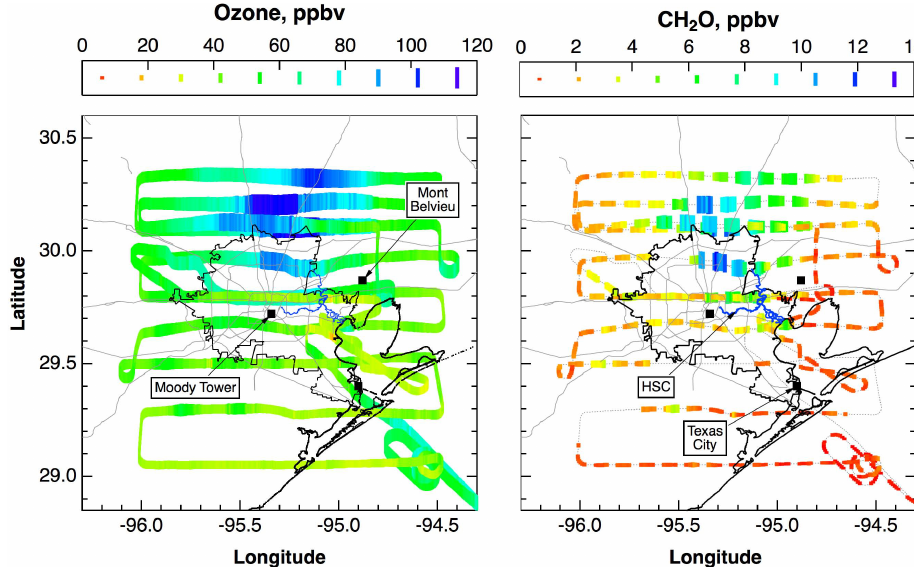
Fig. 1. Distributions of ozone (left) and formaldehyde (right) downwind of the HSC measured by the Electra aircraft during TexAQS 2000. The data were collected between 12:00 and 18:00 local standard time, and are plotted on the 27 August 2000 flight track, with the symbols sized and color-coded according to the measured mixing ratios of the respective species as indicated by the keys above each plot. During this flight, measured winds were southerly (wind direction = 162 ± 17 ◦ ) and steady (wind speed = 5.4 ± 1.5 ms − 1 ), where standard deviations of the respective quantities are indicated. Text boxes with arrows indicate approximate locations of specific petrochemical complexes and a measurement site referred to in the